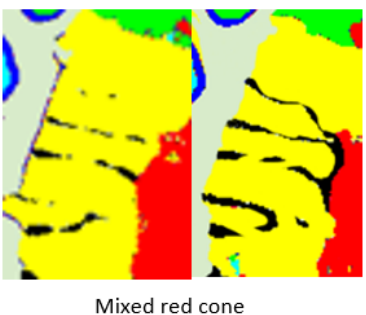
Figure 9. Local map of weakened tree species mixing using CRF.